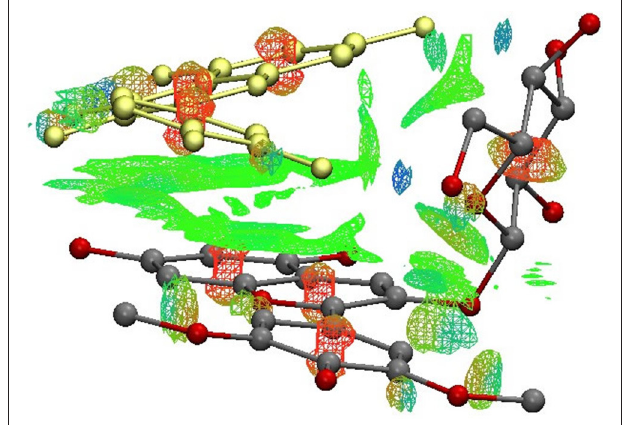
FIGURE 2 | Visualization of non-covalent interactions (Green = weack interactions, Red = repulsive interactions, Blue-red = attractive interactions) in complex 5 .